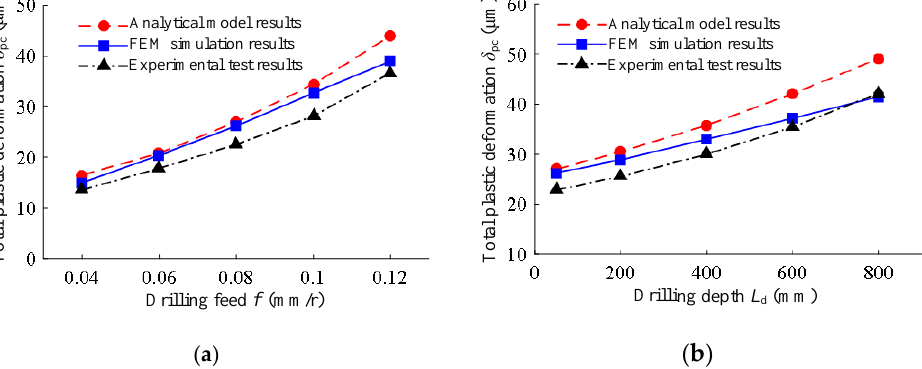
Figure 14. The total plastic deformation of the hole wall under different drilling conditions: ( a ) under different drilling feeds of drilling speed n = 1200 r/min and drilling depth L d = 50 mm; ( b ) under different drilling depths of drilling speed n = 1200 r/min and feed rate f = 0.08 mm/r.